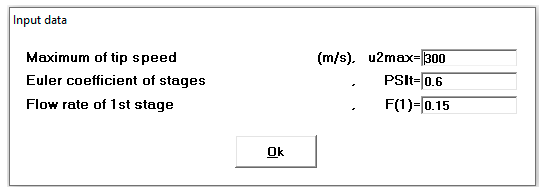
Figure 3. PC software PDCC-G8E for variant calculation and preliminary design: design parameters for the compressor first stage.